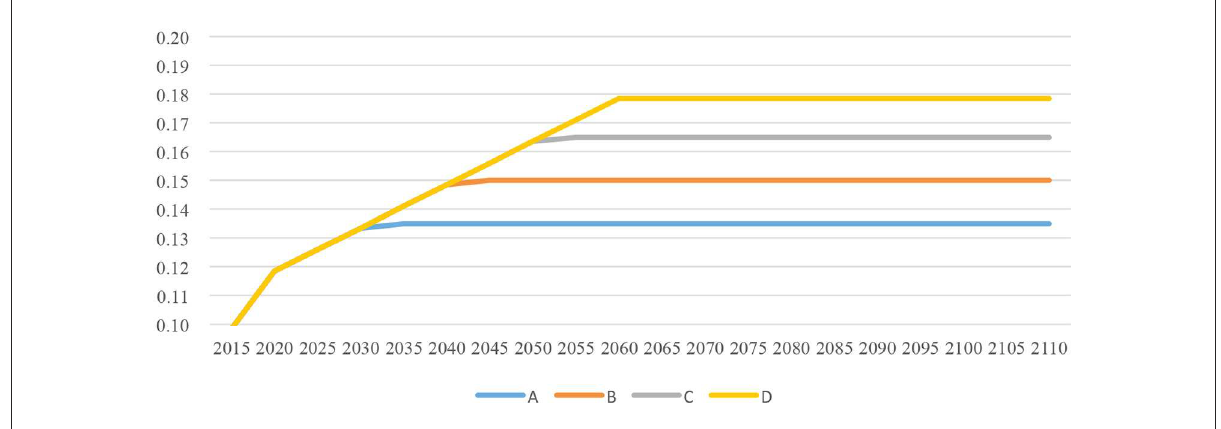
FIGURE1 The proportion of LTCI income in GDP under the four scenarios (%).